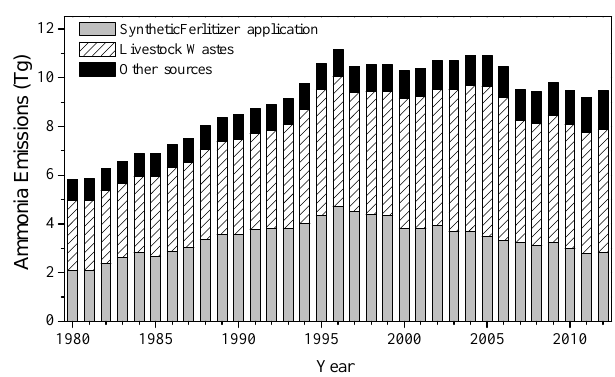
Figure 1. Interannual variation in total NH 3 emissions in China from 1980 to 2012; the sources of the emissions were categorized as synthetic fertilizer application, livestock manure, and other